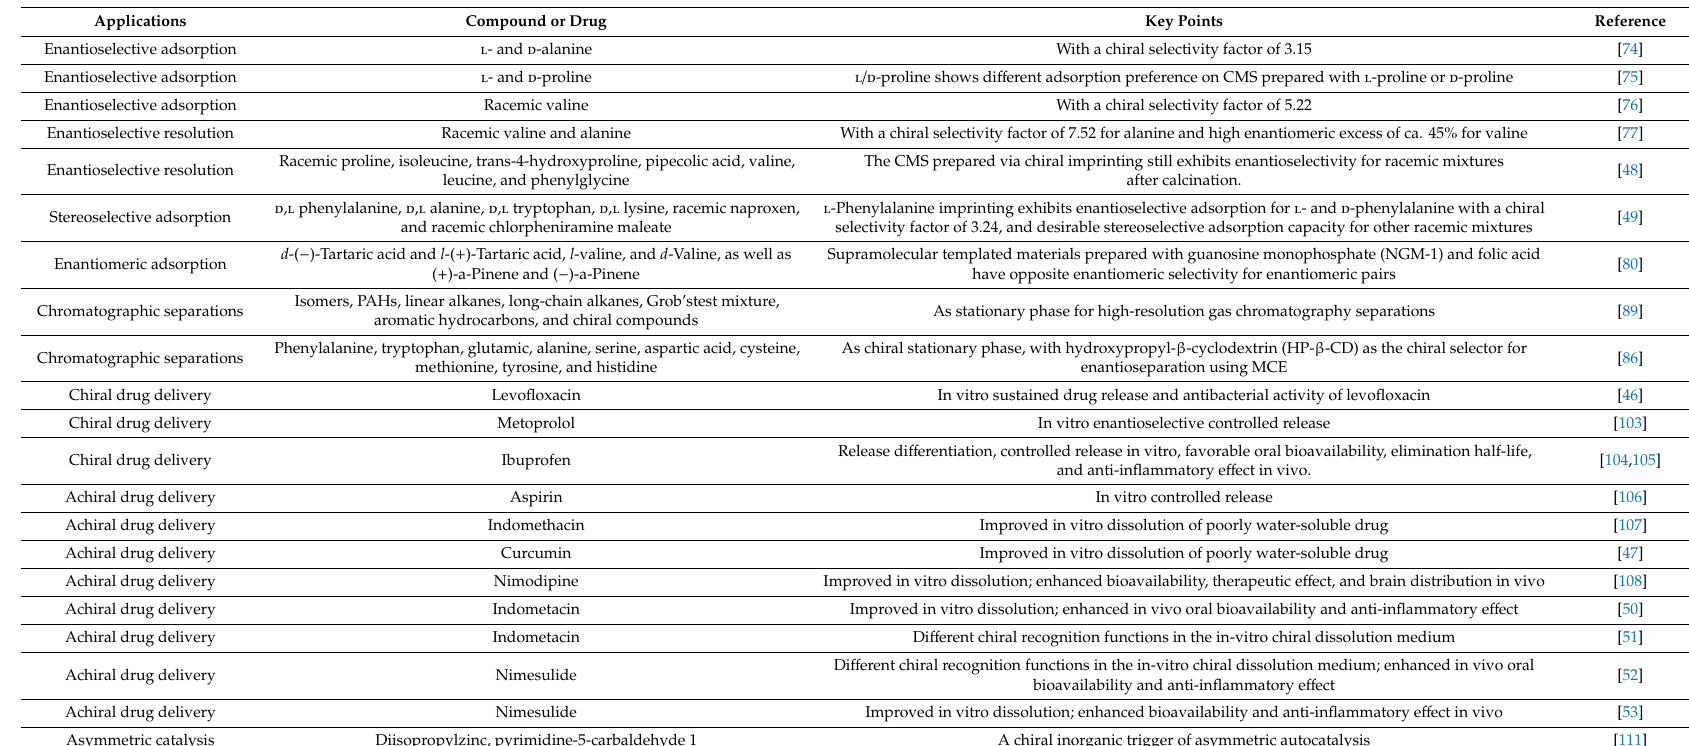
Table 2. Applications of CMS in various